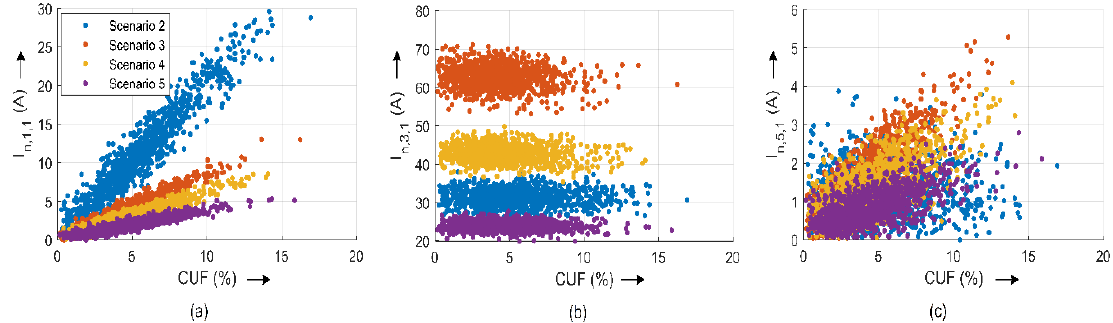
Figure 13. Correlation between the CUF (ratio of negative sequence current to positive sequence current) and selected neutral harmonic currents under sinusoidal supply voltage at analysis point 1: ( a ) fundamental, ( b ) 3rd harmonic, and ( c ) 5th harmonic.